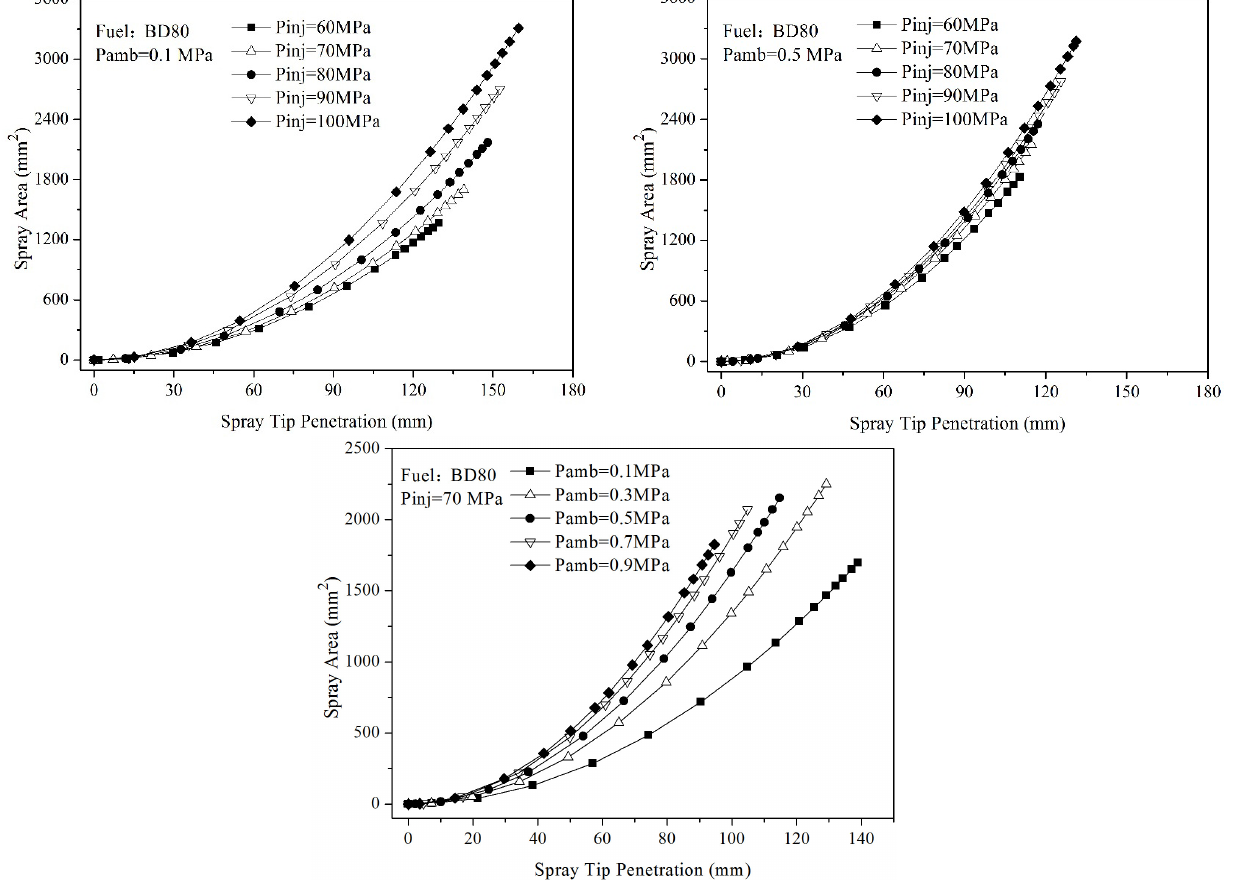
Figure 8. The spray area for BD80 under different